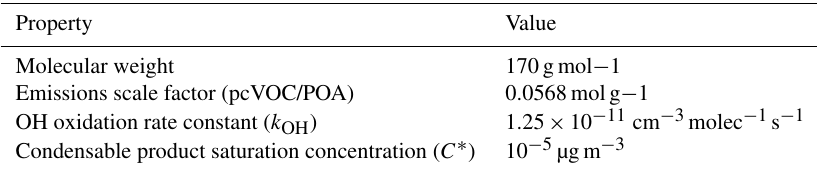
Table 2. Properties of potential SOA from combustion emissions (pcSOA) species and its precursor, pcVOC, for the base case (BASE) CMAQ